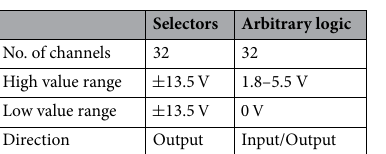
Table 1. Selectors and arbitrary logic